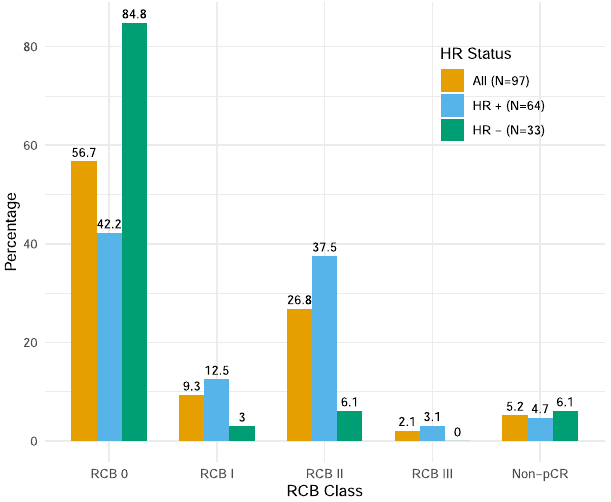
Fig. 2 Pathologic response results. Non-pCR indicates patients who received additional neoadjuvant chemotherapy following paclitaxel/trastuzumab/pertuzumab. HR hormone receptor, pCR pathologic complete response, RCB residual cancer